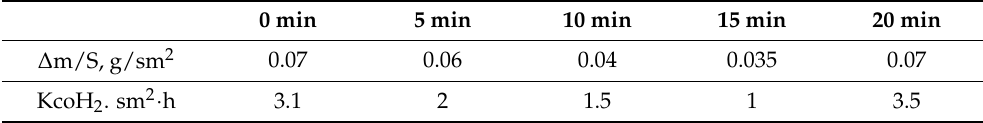
Table 4. The effect of the duration of the EMP treatment on the corrosion of cast iron